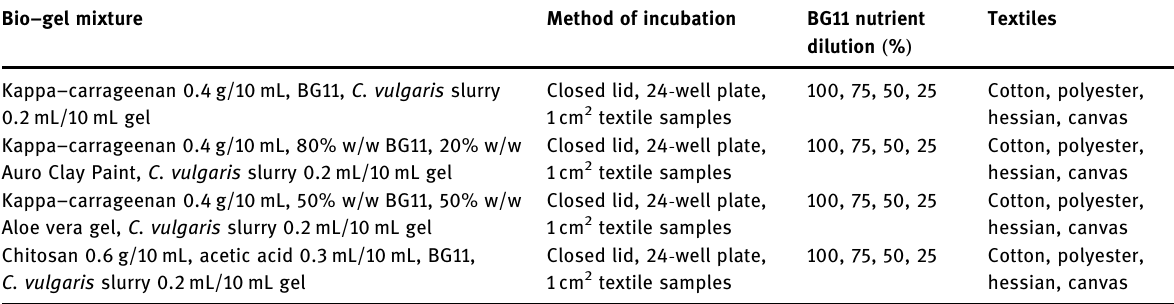
Table 2: Bio – gel mixtures within a closed setup and method of